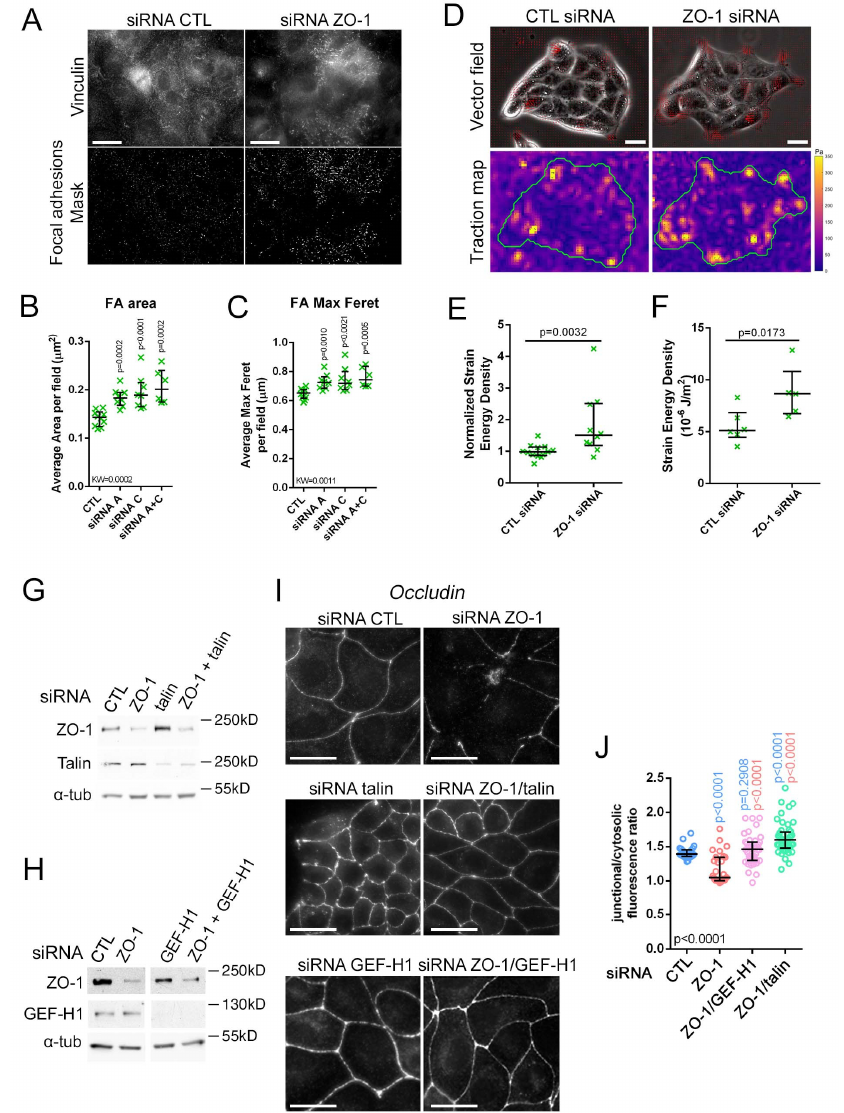
Figure 5. ZO-1 regulates basal adhesion architecture and cell traction on the ECM. ( A – C ) siRNA- transfected MDCK cells were immunostained for vinculin to observe focal adhesions by imaging the most basal z-slices of the cells (( A ), upper images). Binary masks of focal adhesions were computed from the vinculin immunofluorescence images (( A ), bottom images). From the masks, morphological parameters were analysed: adhesion areas ( B ) and the maximal Feret diameters as a measure of elongation (data points represent cells analysed). ( D – F ) TFM performed on siRNA-transfected MDCK cell islands. Traction vector fields were overlaid on phase contrast images (( D ), top) and the corresponding stress maps (( D ), bottom) were computed. Average strain energy densities of all islands in a single gel were normalized to respective controls ( E ) number of gels in each condition and absolute values of single islands of one representative experiment were plotted number of islands in each condition ( F ). The effect of ZO-1 depletion was measured in parallel with that of JAM-A depletion [9]; hence, the same control siRNA values are shown. ( G – J ) MDCK cells transfected with siRNAs as indicated (the total concentration of siRNA was kept constant by adding control siRNA) were plated on glass and were then analysed by immunoblotting ( G , H ) or immunofluorescent staining of occludin ( I , J ). The junctional relative to cytosolic specific fluorescence intensity was quantified as a measure for junction assembly (( J ), data points represent analysed cells, blue p values are for comparisons to control and red values for comparisons to ZO-1 siRNA only). Magnification bars, 20 µ